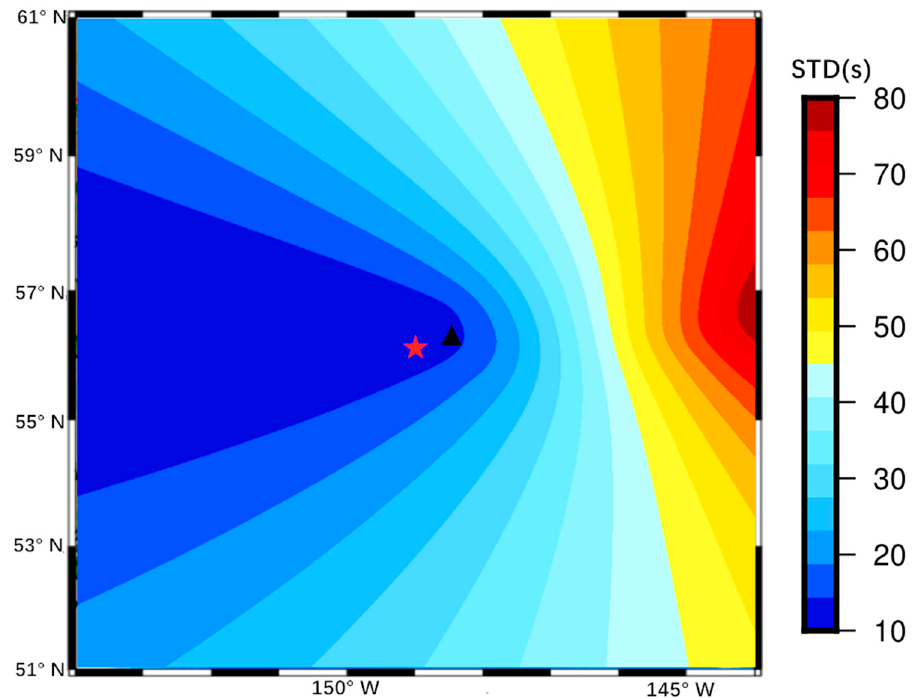
Figure 9. CID source location of the Alaska earthquake, the black triangle represents the CID source location, the red star represents the actual epicenter location, and color depth represents standard deviation (STD).